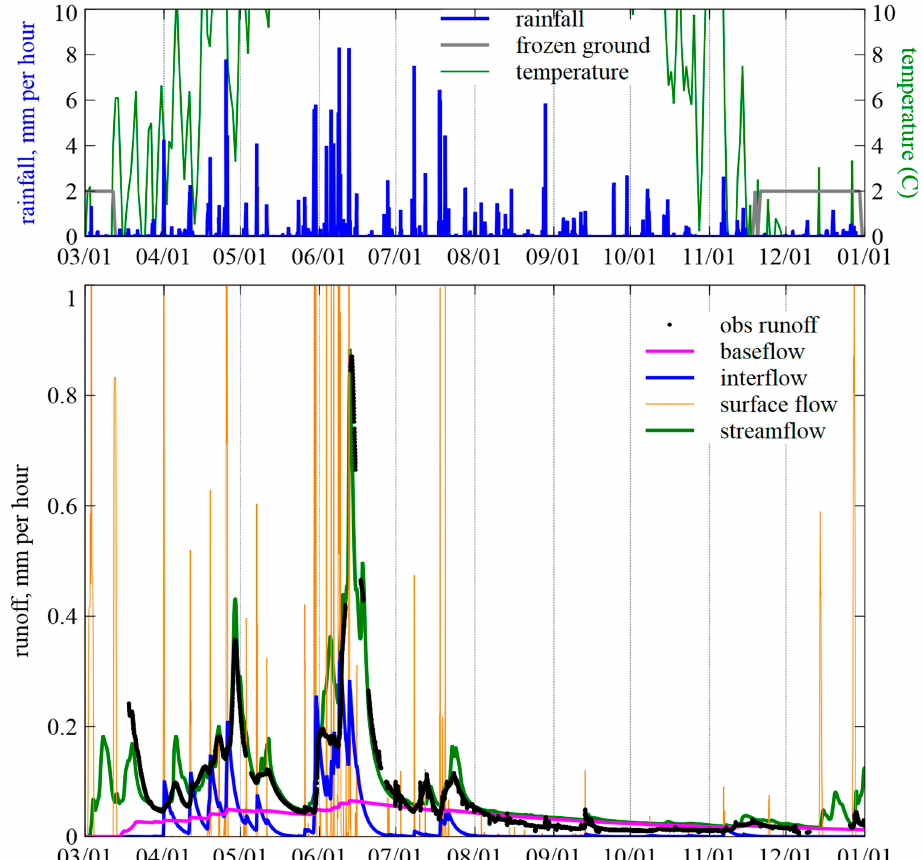
Figure 4. Model simulation in Cedar River at Cedar Rapids from 1 March 2008 to 1 January 2009. The upper panel shows basin average rainfall and temperature. The gray line indicates when ground is frozen. Bottom panel shows the decomposition of streamflow simulations into surface flow, interflow and baseflow. We checked the mass conservation during the time period shown in Figure 4 for the precipitation input and flow components. The basin total rainfall accumulation is 1021 mm; total runoff is 596 mm; total overland flow is 222 mm, which is 37% of total runoff; total interflow is 141 mm, which is 23% of total runoff; and total baseflow is 233 mm, which is 39% of total runoff. There are 15 mm of water that remain stored in the soil at the end of the time period.